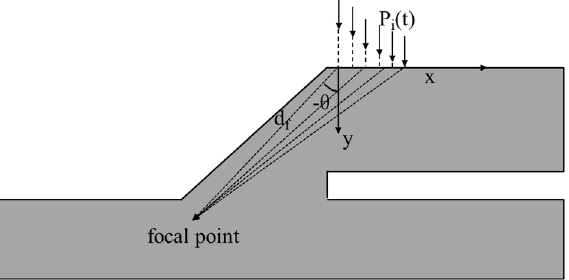
Figure 2. Numerical model of PAUT of the type-B sleeve fillet weld defects.